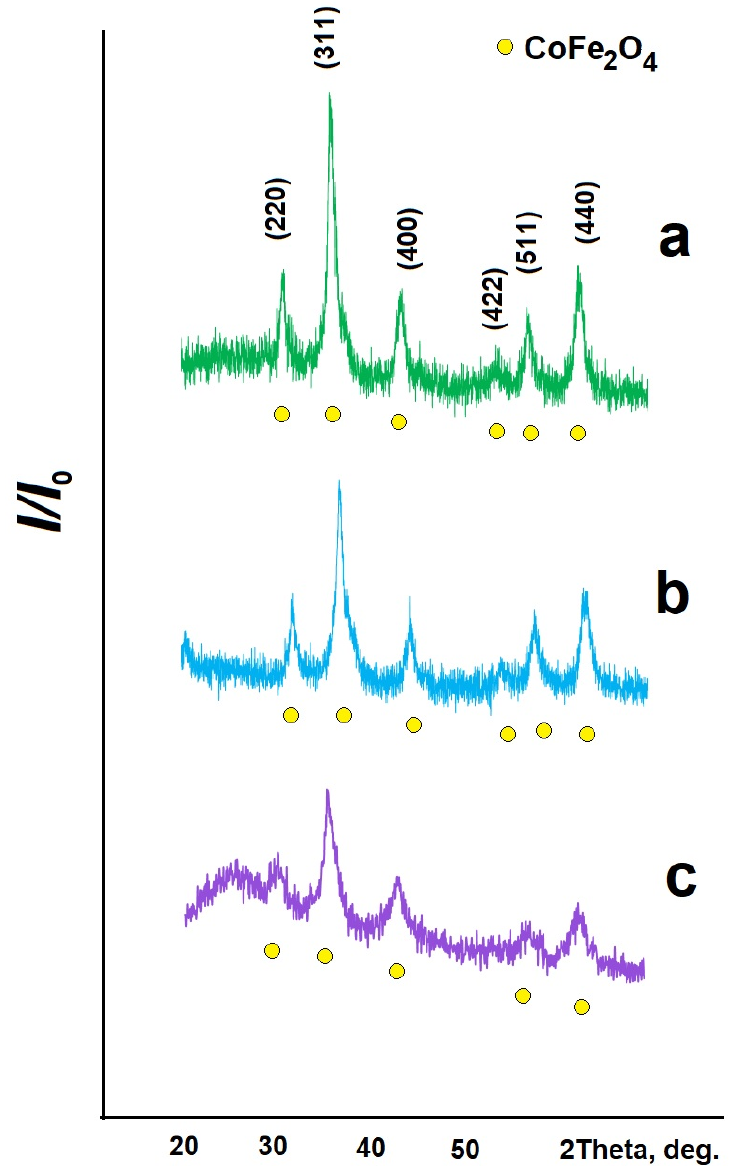
Figure 1. X-ray pattern of synthesized samples: ( a )—CoFe 2 O 4 , ( b )—CoFe 2 O 4 /C, ( c )—CoFe 2 O 4 /S. Table 1. Synthesized materials characteristics.